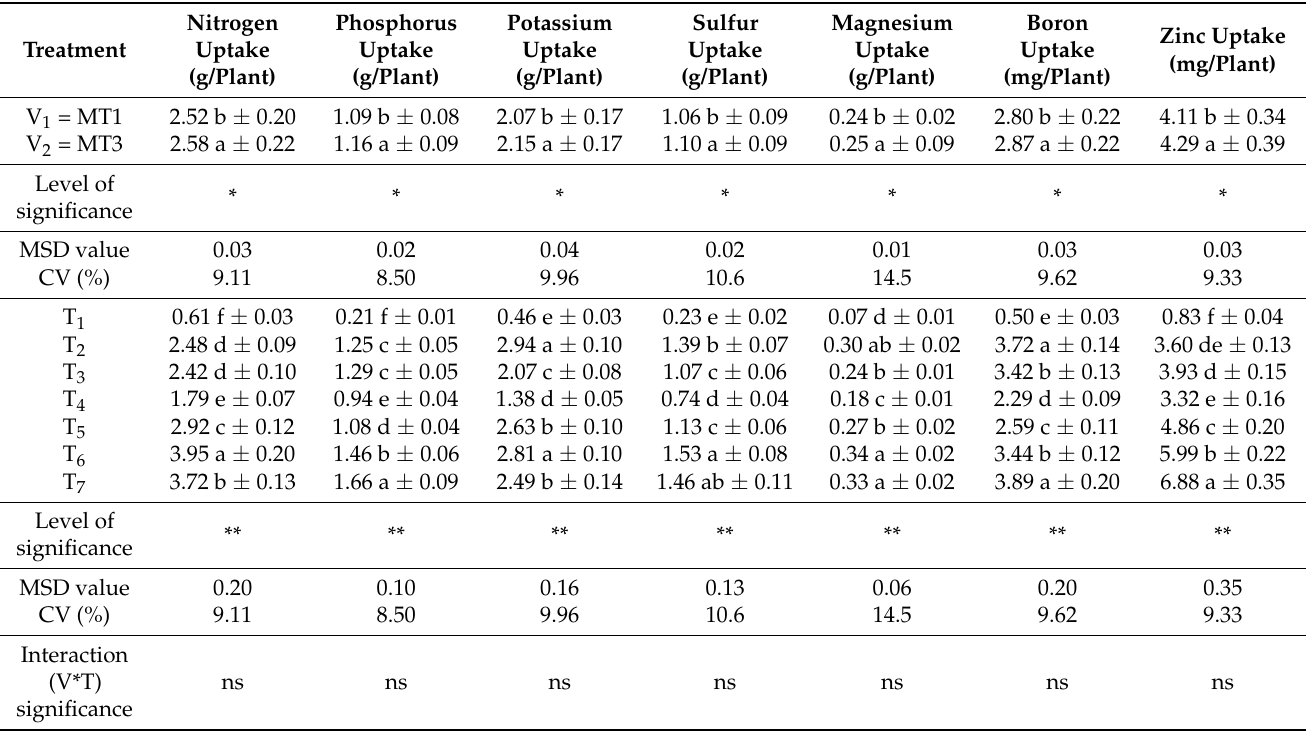
Table 12. Effect of zinc fertilizer and zinc oxide nanoparticles on nitrogen, phosphorus, potassium, sulfur, magnesium, boron, and zinc uptake by fruits of two selected tomatoes